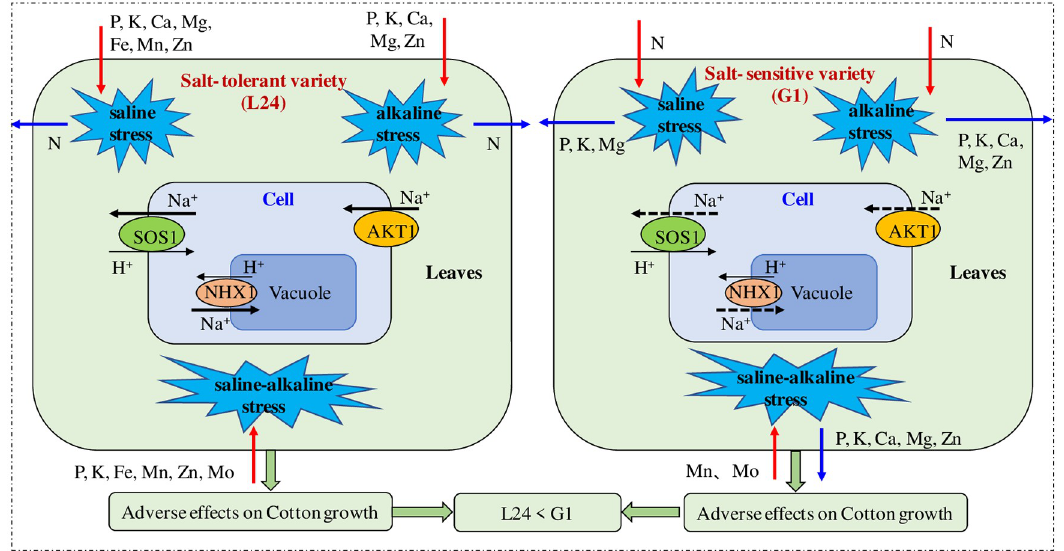
Fig 9. Response of ion content and gene expression in salt-tolerant variety and salt-sensitive variety to saline, alkaline and saline-alkaline stresses. The red arrow indicates the increase of ion content and the blue indicates the decrease; The black solid line indicates that the up-regulating of gene expression is relatively large, and the dotted line indicates that the up-regulating is relatively